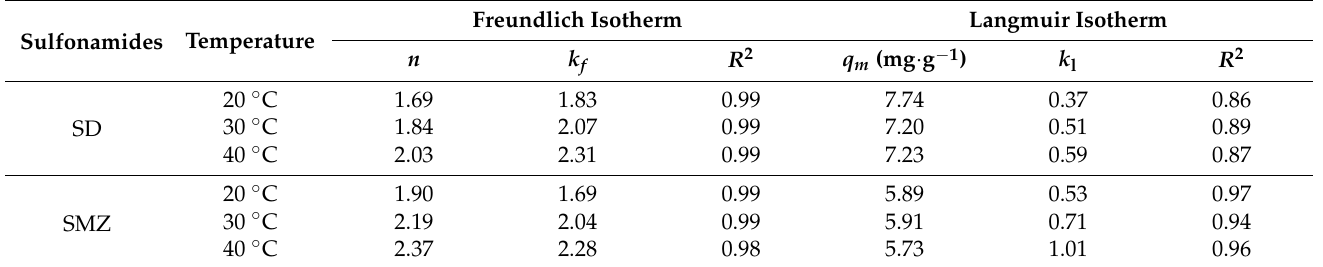
Table 3. Isotherm parameters for the adsorption of sulfonamide by ATP/BC-0.1.